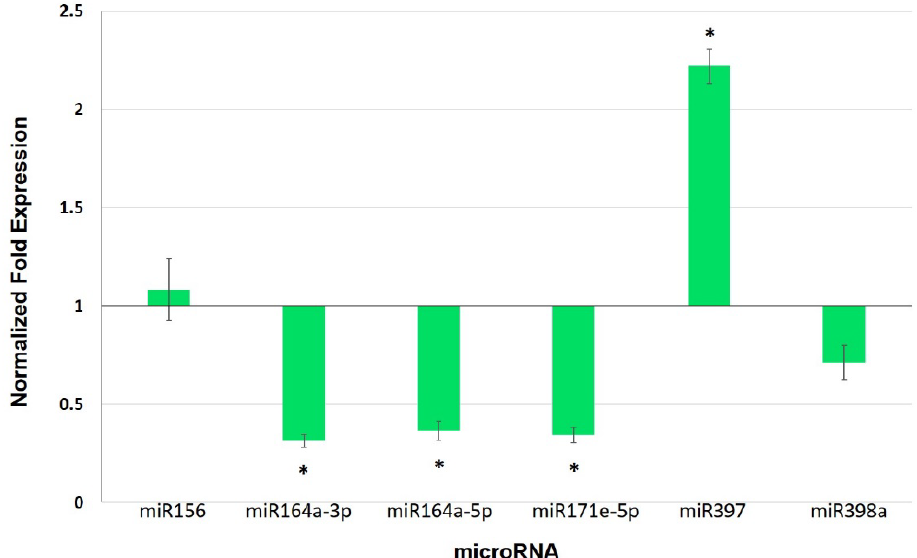
Figure 5. Normalized fold expression levels of selected miRNAs in leaves of mycorrhizal tomato plants. Expression was determined by qRT-PCR (2 −∆∆Ct ). Values represent the average ±SE of the normalized relative expression (MYC/CTR) from three independent biological experiments (n = 3 per experiment). U6 was used as a reference gene for data normalization. (*) represent significantly different means between MYC/CTR according to the statistical analysis (Student’s t -test, p ≤ 0.05). Bars, ±SE.